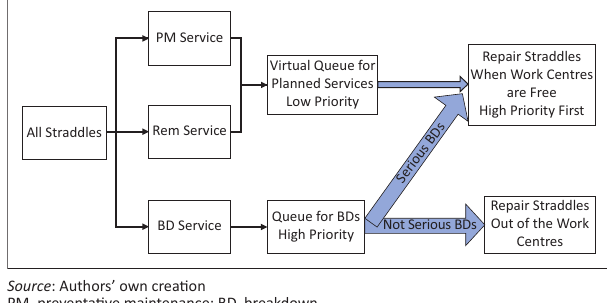
FIGURE 3: Workflow of